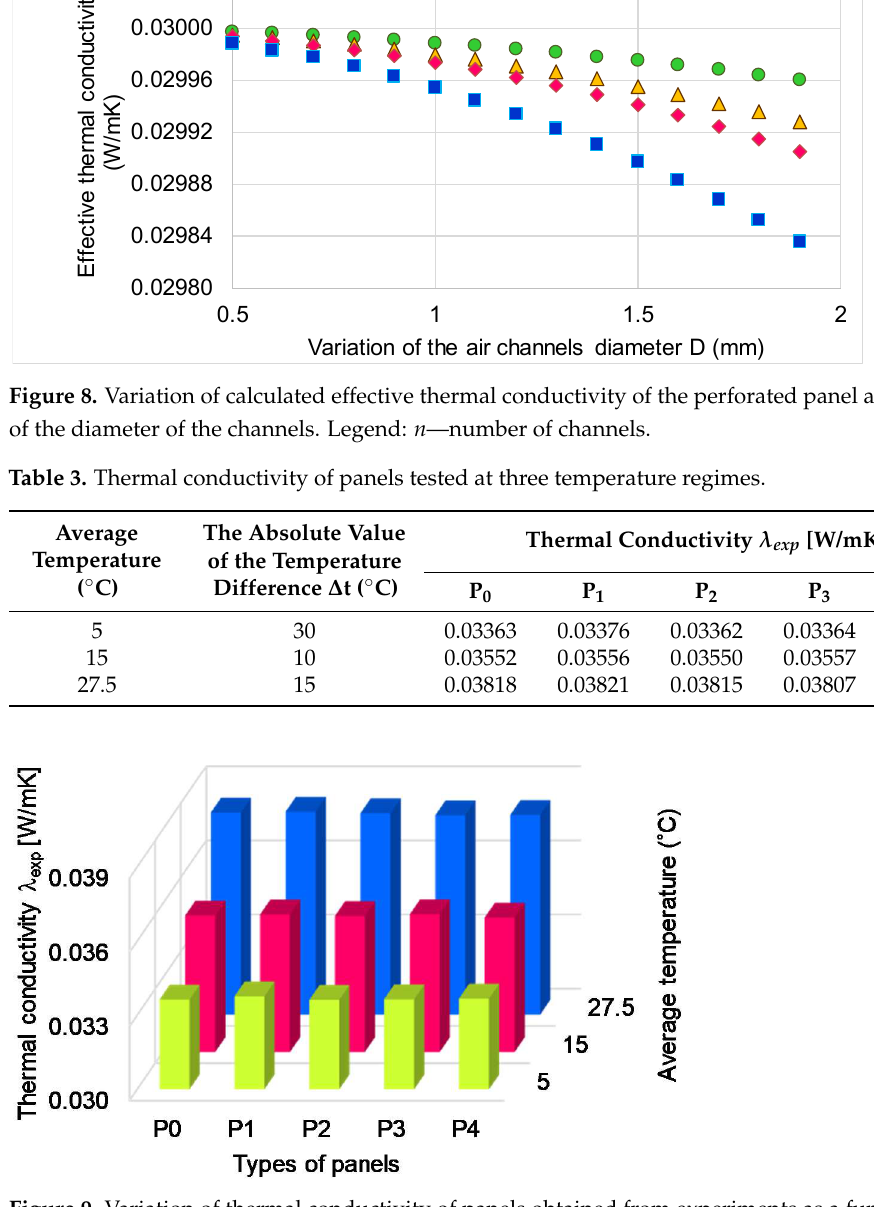
Table 3. Thermal conductivity of panels tested at three temperature regimes.